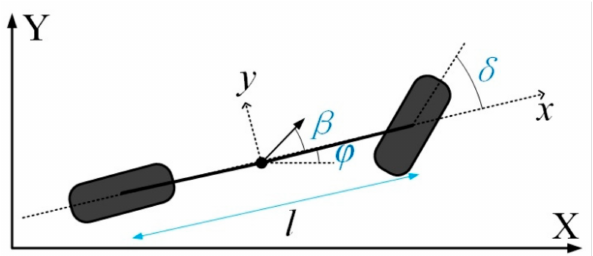
Figure 3. Kinematic rear axle bicycle model of the